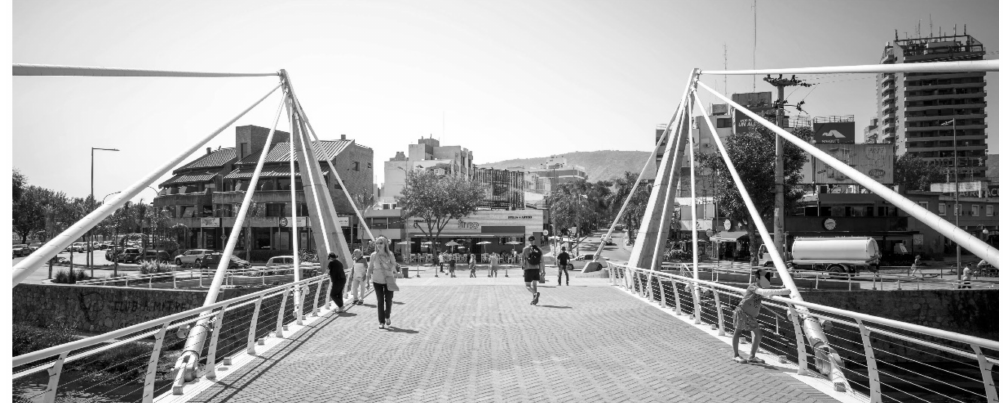
Figure 19. Pedestrian view looking towards the east precinct from 1